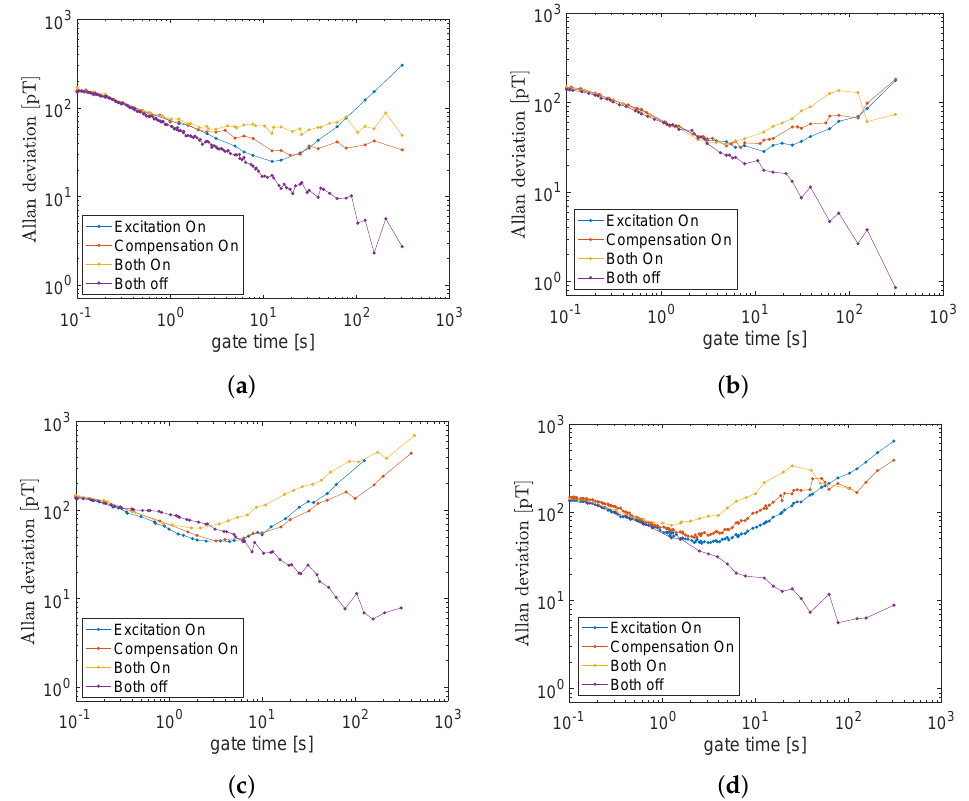
Figure A2. Allan deviation of 10 minute (unshielded) noise measurements with (i) excitation coil on, (ii) compensation coil on, (iii) both coils on, and (iv) no coils on at ( a ) 10 Hz, ( b ) 120 Hz, ( c ) 500 Hz, and ( d ) 1000